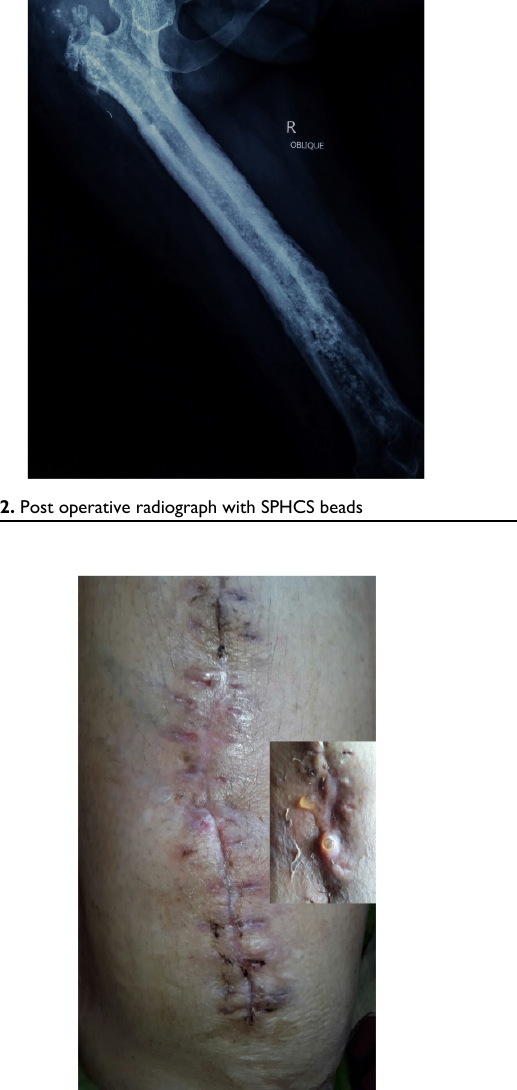
In cases where SHPCS or other calcium